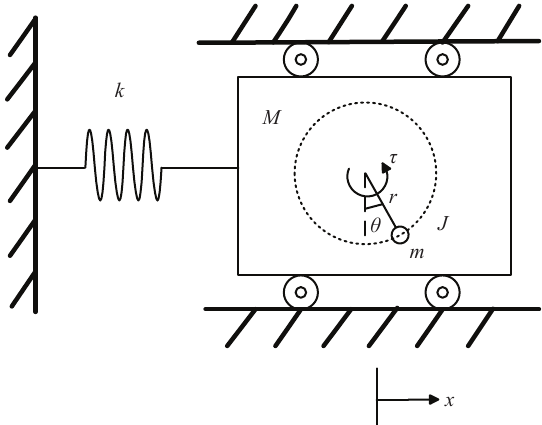
Figure 1. Structure diagram of underactuated horizontal TORA